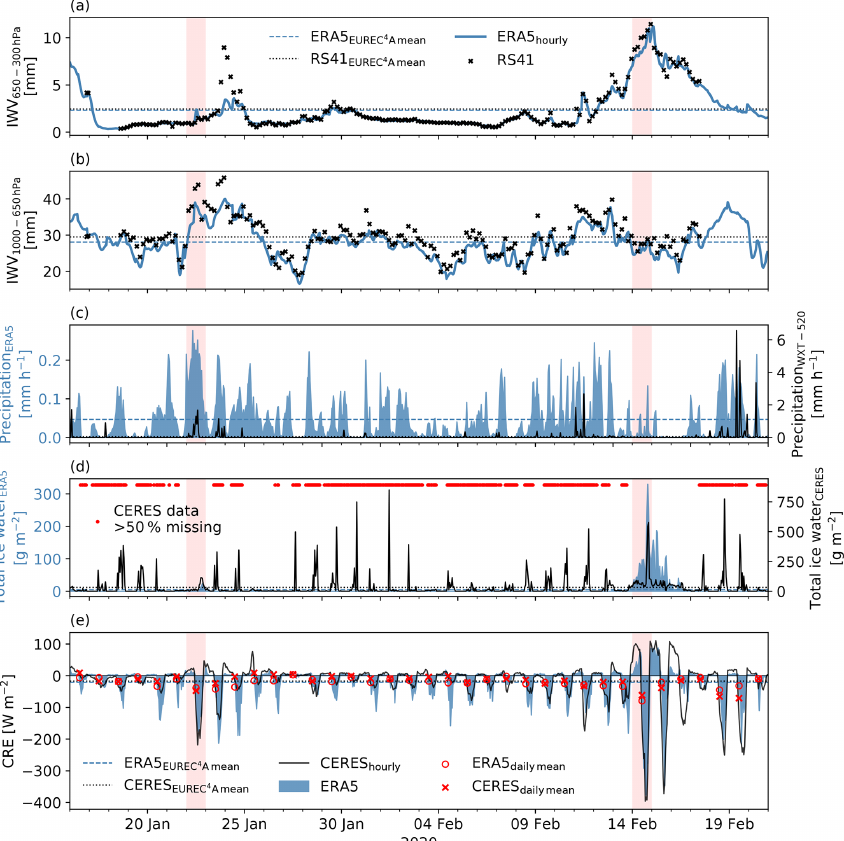
Figure 3. Time series of the environmental conditions at the BCO during EUREC 4 A. Shown are (a) IWV 650–300hPa and (b) IWV 1000–650hPa from ERA5 and the BCO soundings, (c) hourly precipitation totals from ERA5 and the WXT-520 weather station (note the differently scaled y axes), (d) total ice water from ERA5 and CERES (note that missing data in CERES was filled with linear spatial interpolation; if more than 50% of the data points in a 10 ◦ × 10 ◦ domain centered around the BCO were missing, the time step is marked with a red dot at the panel top), and (e) CRE from ERA5 and CERES. The red shadings highlight the periods of the two case studies, i.e., 22 January and 14 February 2020. The time axis is given in UTC (Barbados local time: UTC −